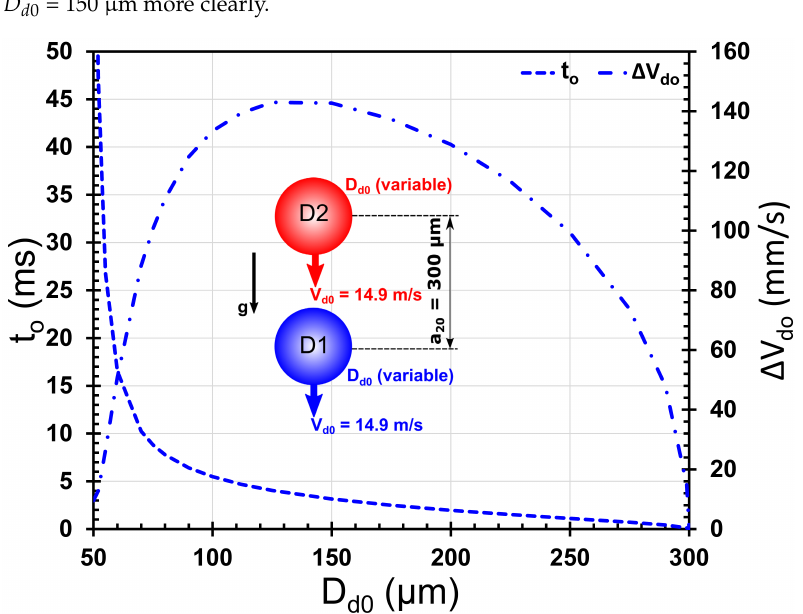
Figure 6. Effect of D d 0 on a 2 ( t ) : ( a ) Time evolution of the center-to-center separation of iso-propanol droplets in the double-droplet system corresponding to the cases shown in Figure 5, as predicted by Equations (11–13). ( b ) Non-dimensionalized version of the plot shown in ( a ) using the non-dimensionalization discussed in Appendix C. In the vertical axis, the factor (cid:20)(cid:16) (cid:17)(cid:21) (cid:17) 2 (cid:16) (cid:17) 2 (cid:30)(cid:16) a 20 2 a 20 2 a 20 + 1 − 1 ψ = . The inset shows a magnified version to show the trend for D d 0 D d 0 3 3 D d 0 D d 0 = 150 µ m more clearly.